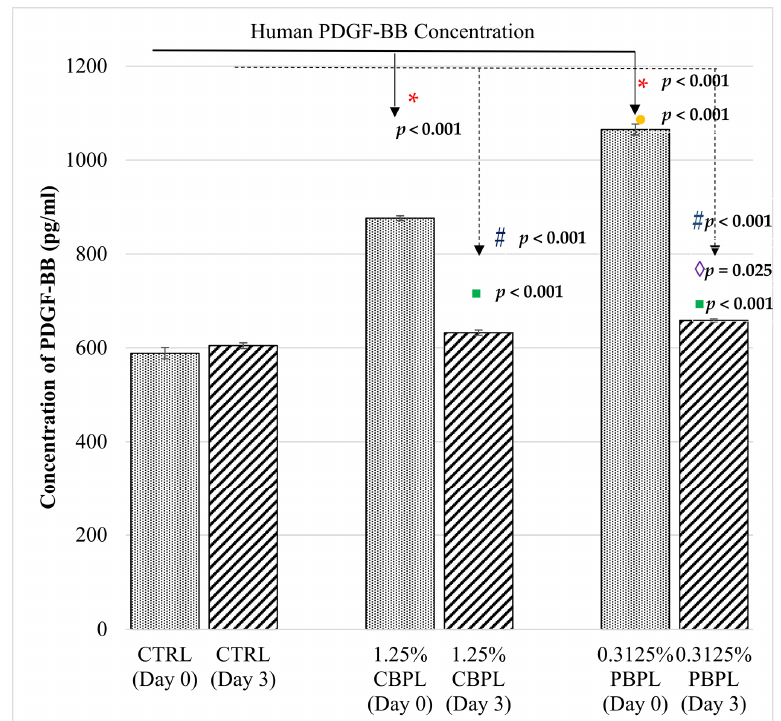
Figure 5. Human PDGF concentrations among CTRL, 1.25% CB-PL and 0.3125% PB-PL groups in a wound-healing assay on day 0 and 3. All data were representative of three independent tests with